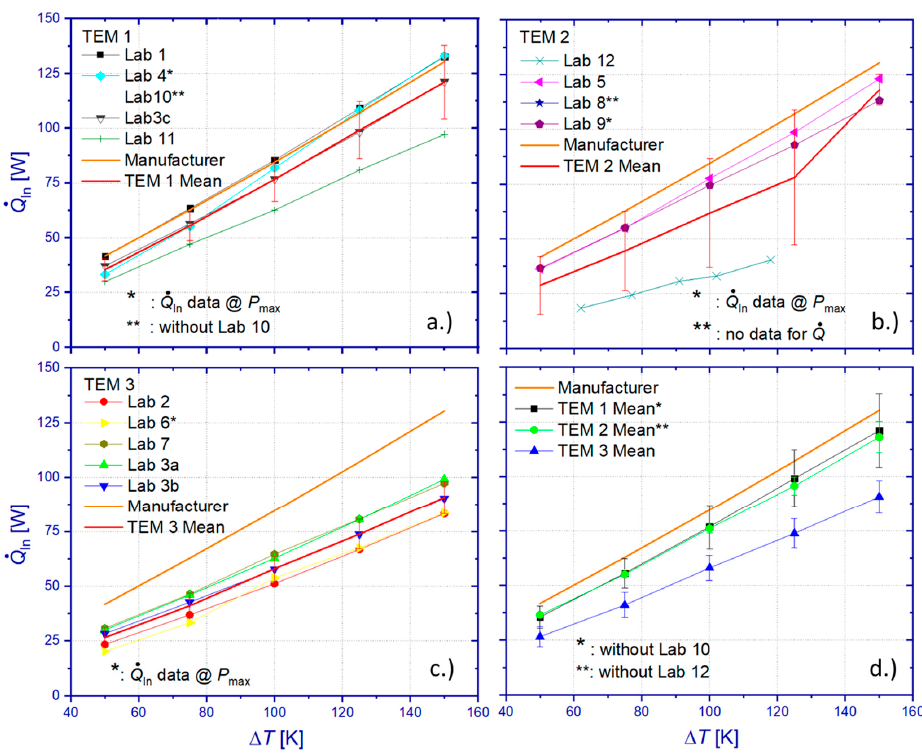
Figure 11. RR results for incident heat flow Q In at maximum efficiency in dependence on the temperature difference ∆ T , shown separately for TEM1 (( a ) without Lab 10), TEM2 ( b ), and TEM3 ( c ). Mean values and standard deviation displayed by error bars have been calculated excluding certain data sets as indicated and compared to manufacturer specifications. Comparison among the mean values for the TEM is shown in ( d ).